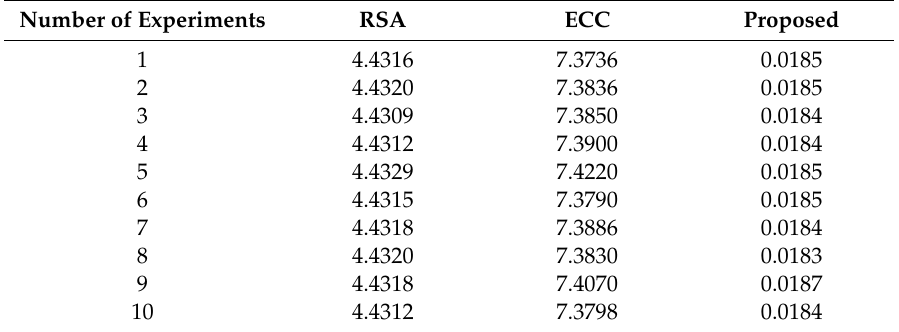
Table 4. Elapsed time (ms) to check decoding speed when using RSA, ECC, and proposed algorithms.